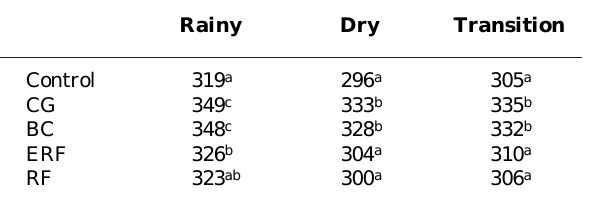
Table 5. Tukey test for water storage means, Table 6. Analysis of variance for soil water storage, considering three climatic periods (wet, dry considering four treatments and three climatic and dry-wet transition) among the treatments periods: wet, dry and dry-wet transition produced in 1993: control, gap centre (CG), gap edge (BC), edge of remaining forest (ERF) and remaining forest (RF). Rainy Dry